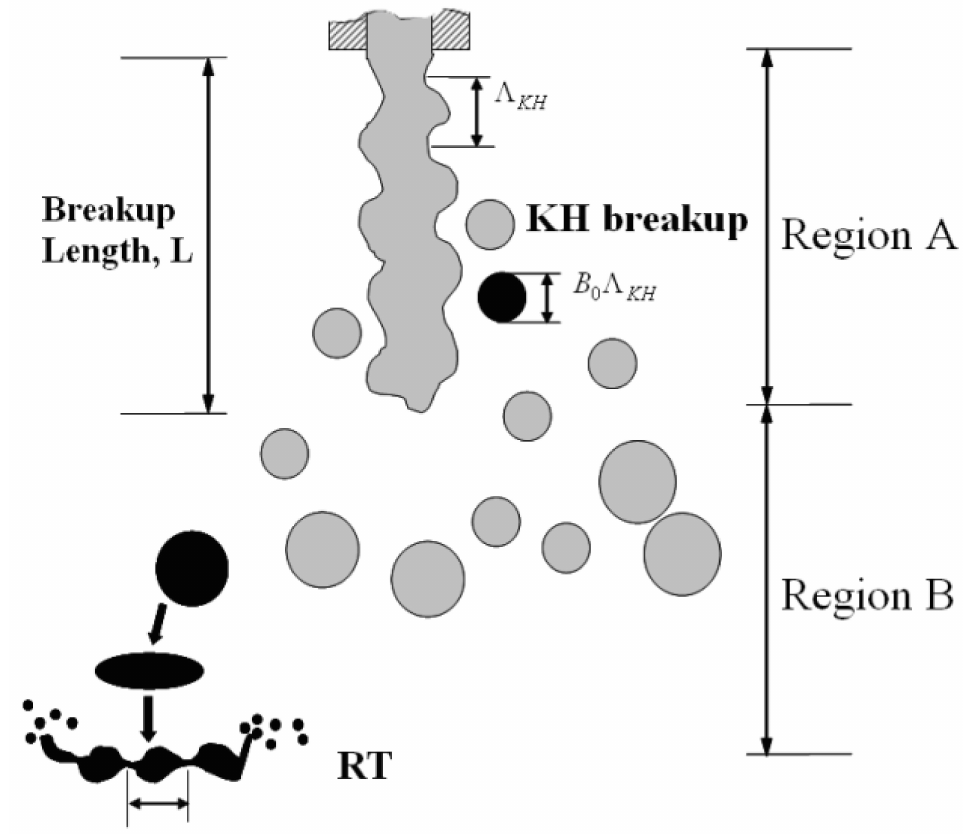
Figure 1. KH / RT breakup model